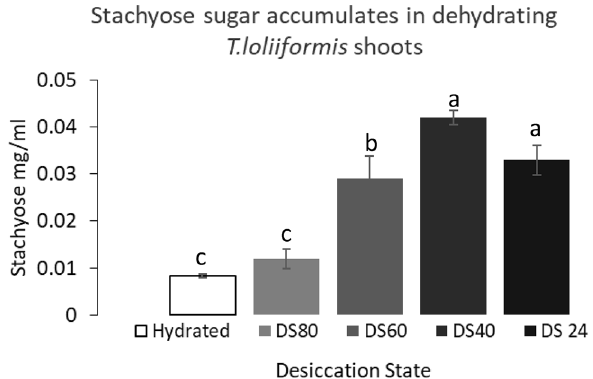
Figure 2. Stachyose sugar accumulation in in dehydrating T.loliiformis shoots. All samples measured using triplicate biological replicates. Stachyose accumulation presented as means at p < 0.05 using Minitab software